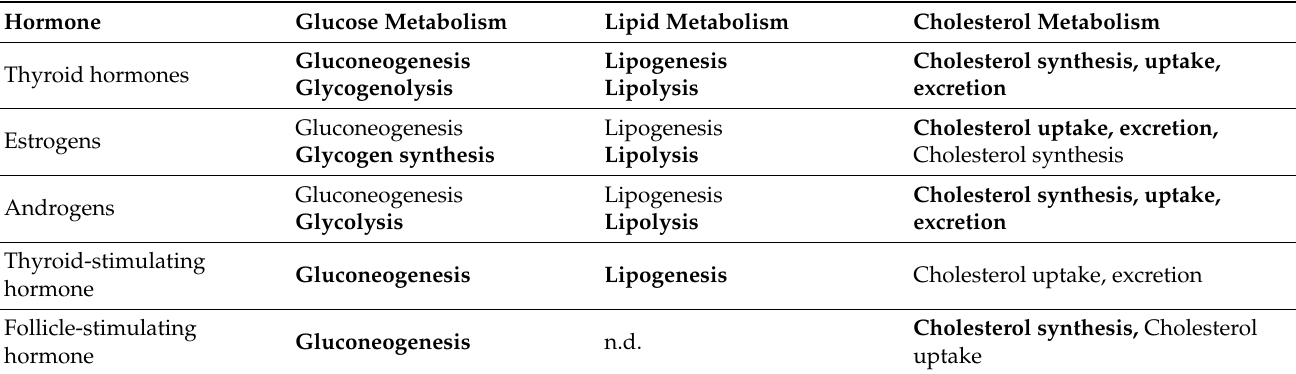
Table 1. Effects of thyroid hormones, estrogens and androgens on hepatic glucose, lipid and choles- terol metabolism. Upregulated processes are written in bold, downregulated processes in regular font. Abbreviation: n.d., no effects reported in